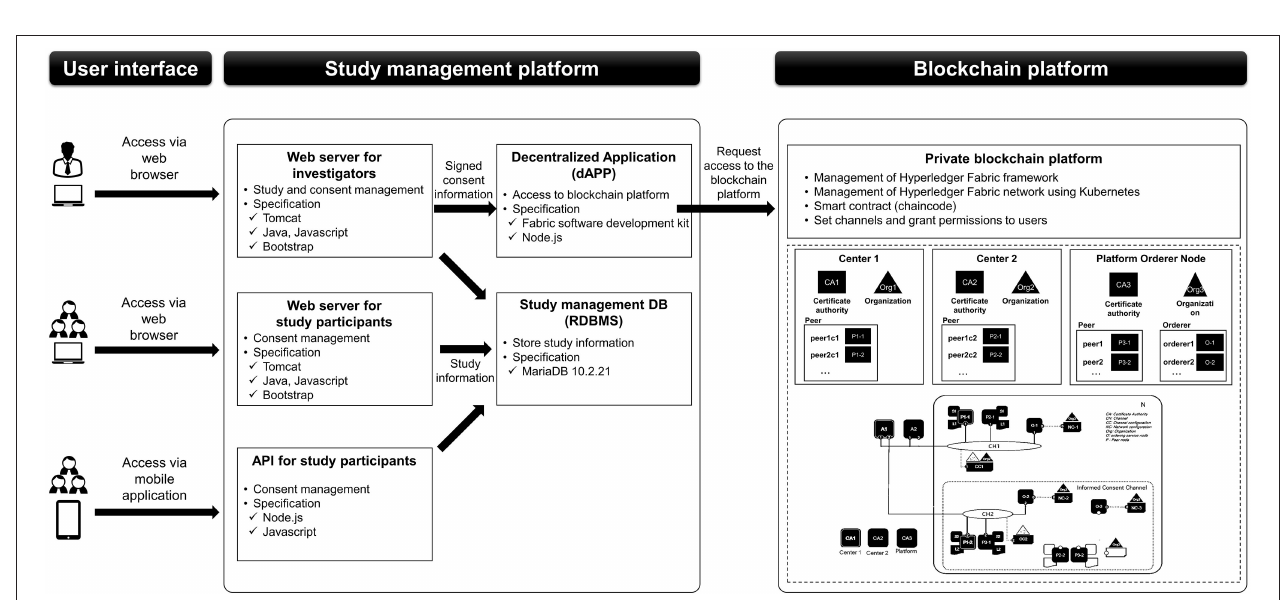
FIGURE 1 | Schematic representation of the development process.